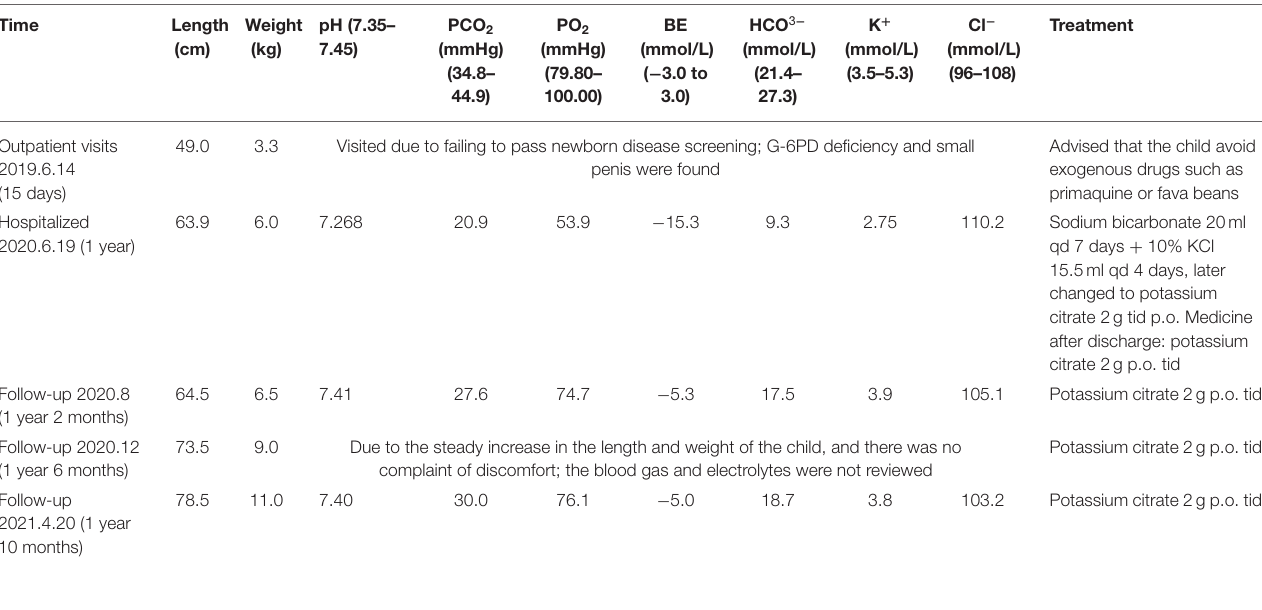
TABLE 2 | Timeline for the treatment and